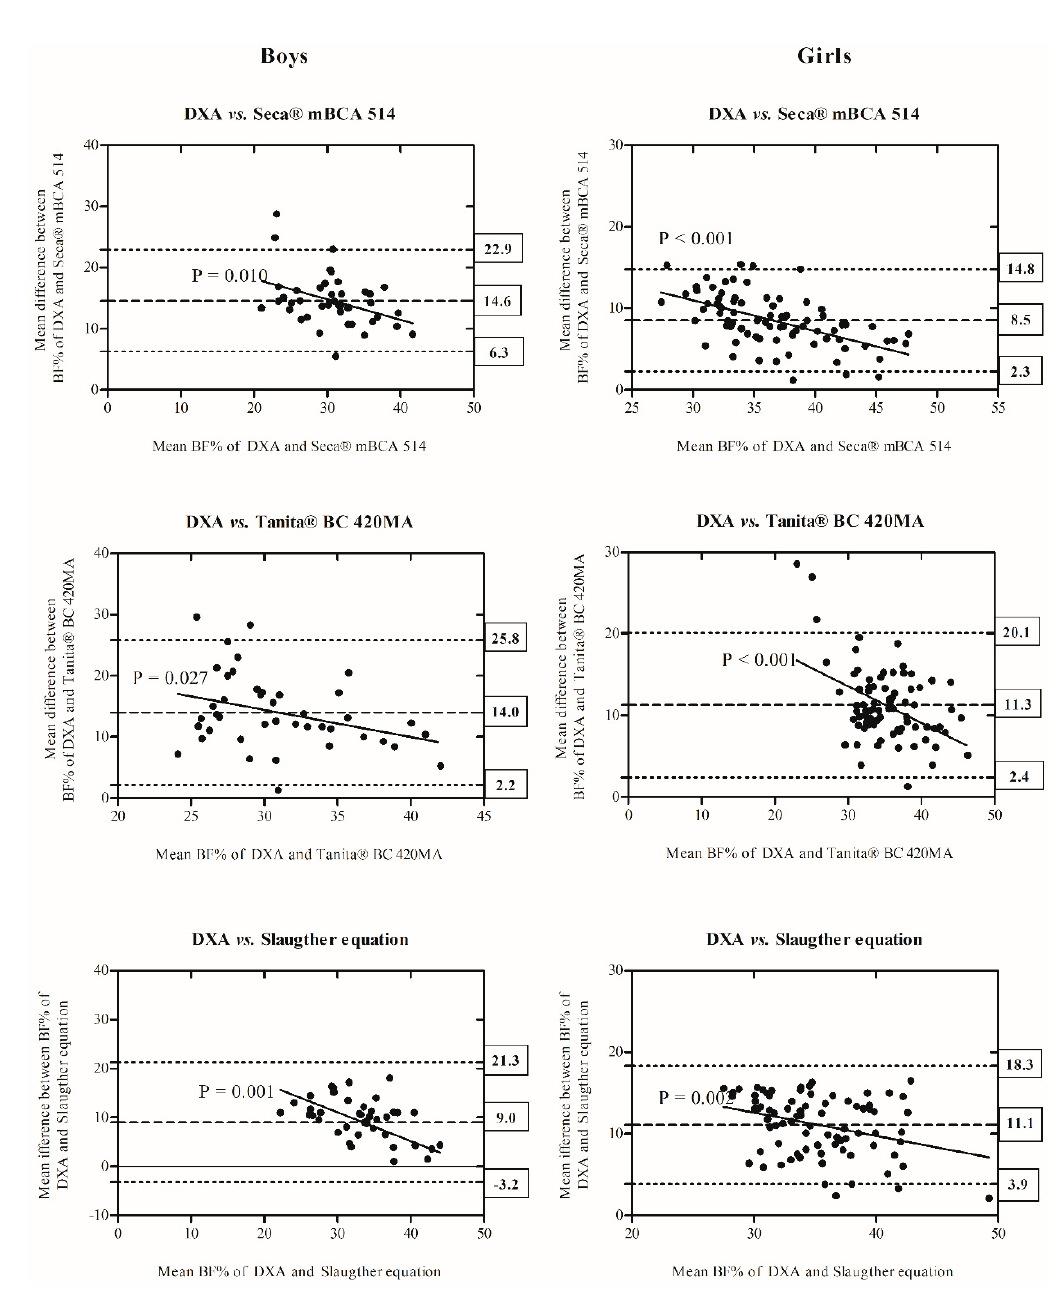
Figure 1. Comparison of BF% measured by DXA in comparison with Seca ® mBCA 514, Tanita ® BC 420MA, and Slaughter equations and displayed as Bland–Altman plots in boys and girls. The central line represents the mean bias between measurements. Dotted lines represent upper and lower limits of agreement. Y-axis represents difference of BF% measured by DXA minus BF% measured by Seca ® mBCA 514, Tanita ® BC 420MA or from skinfolds, respectively. The solid line and equation in each plot represent the linear regression between biases and body fatness by each method (DXA vs. Seca ® mBCA 514; DXA vs. Tanita ® BC 420MA and DXA vs. Slaughter equations). Abbreviations: BF%: body fat percentage; DXA: dual energy X-ray absorptiometry.